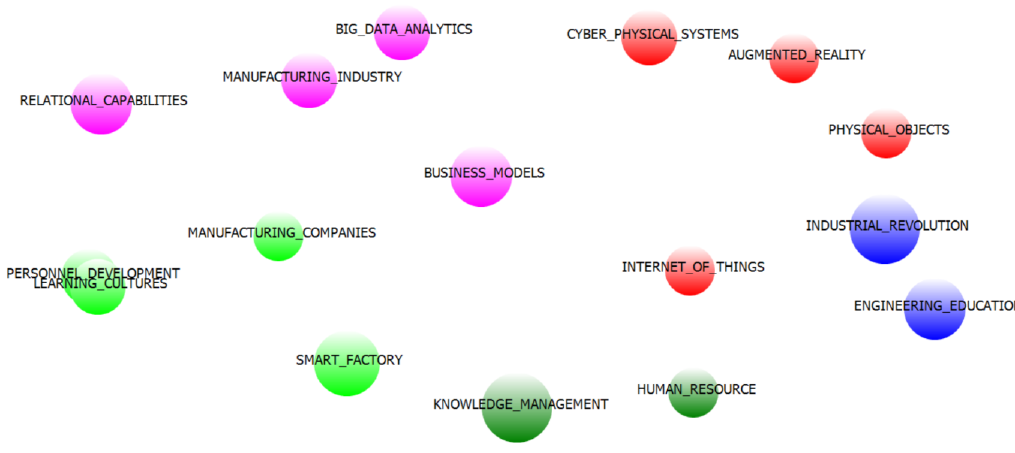
Figure 3. Mapping of clusters.